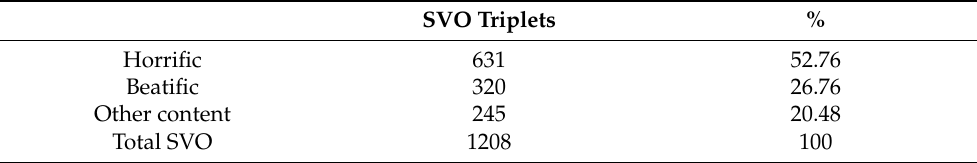
Table 2. Dimensions of fantasy in Trump’s Twitter